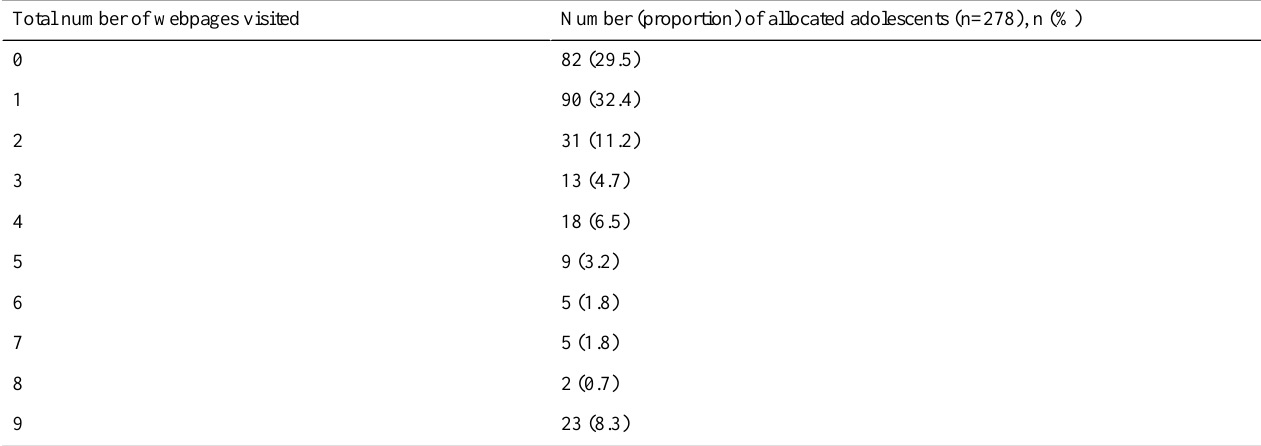
Table 5. The total number of anxiety-based resource webpages visited by allocated